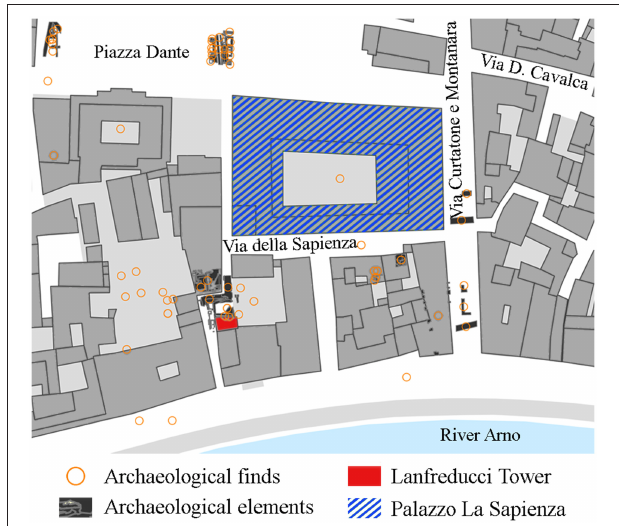
FIGURE 5 | Map of archaeological finds in the area of the tower (MappaGIS) 1